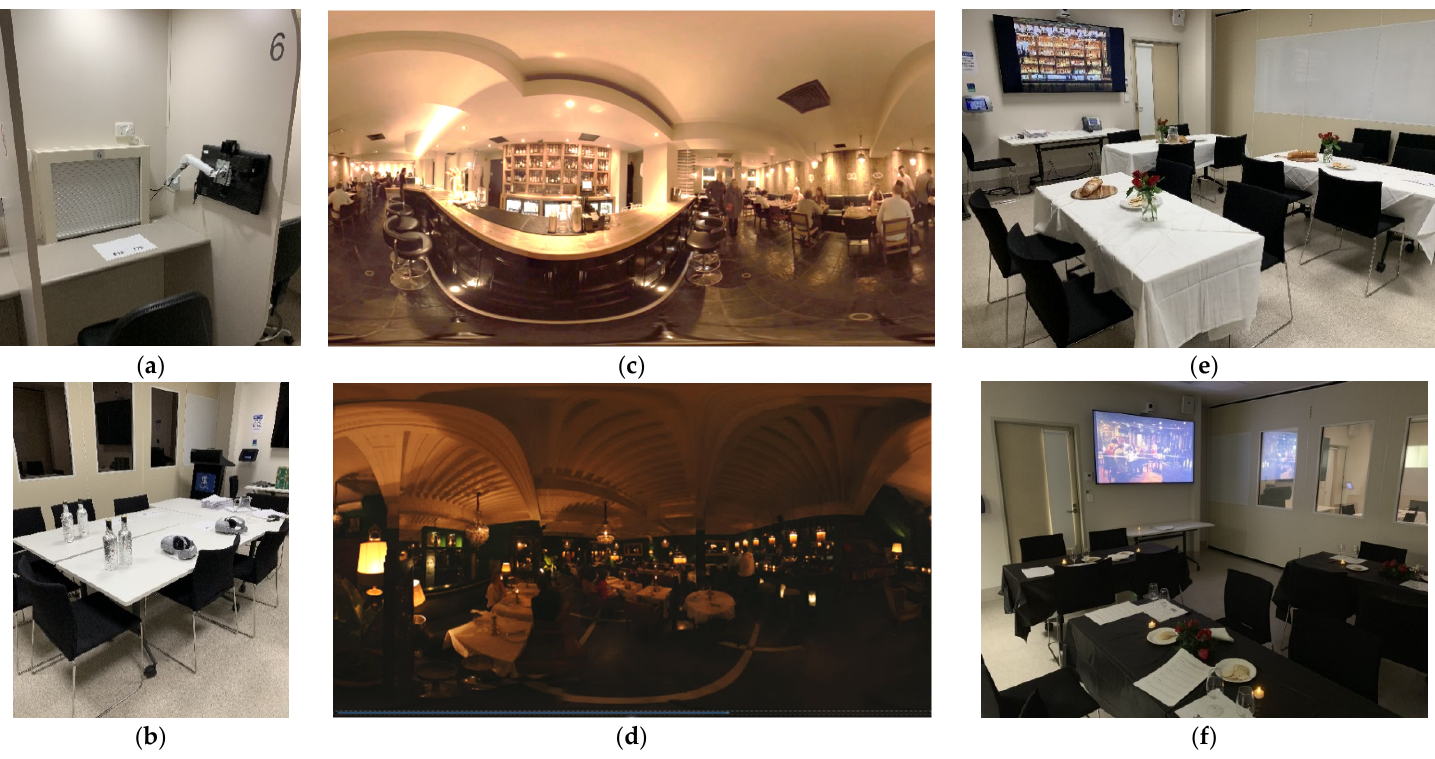
Figure 1. Experimental settings 1 for the sensory evaluation of the wine. 1 ( a ) Traditional sensory booths; ( b ) VR set-up; ( c ) bright restaurant VR environment; ( d ) dark restaurant VR environment; ( e ) bright real restaurant environment; and ( f ) dark real restaurant environment.